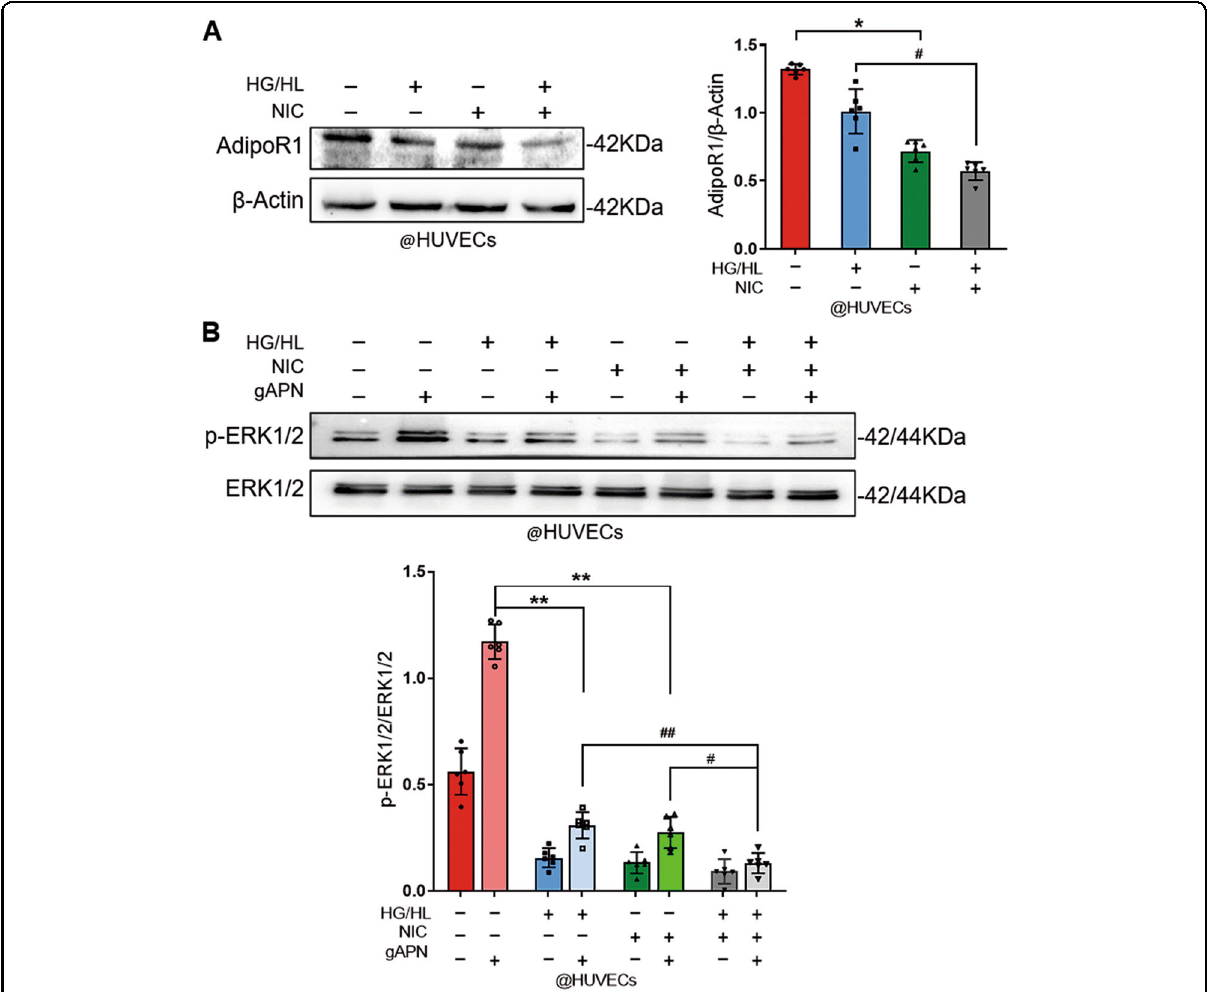
Fig. 2 Nicotine induced and accelerated APN resistance in diabetic endothelial cells. A The expression of AdipoR1 in HUVECs after nicotine and HG/HL treatment. n = 6 dishes/group. * P < 0.05 vs. control group; # P < 0.05 vs. HG/HL group. Data were analyzed by one-way ANOVA. B APN-induced ERK1/2 phosphorylation was suppressed in the presence of nicotine or HG/HL and further inhibited in nicotine combined HG/HL treatment. n = 6 dishes/group. ** P < 0.01 vs. control + gAPN group; ## P < 0.01 vs. NIC + HG/HL + gAPN group. Data were analyzed by two-way ANOVA. NIC, nicotine; HFD, high-fat diet; ND, normal diet; HG/HL, high glucose/high lipid; gAPN, globular